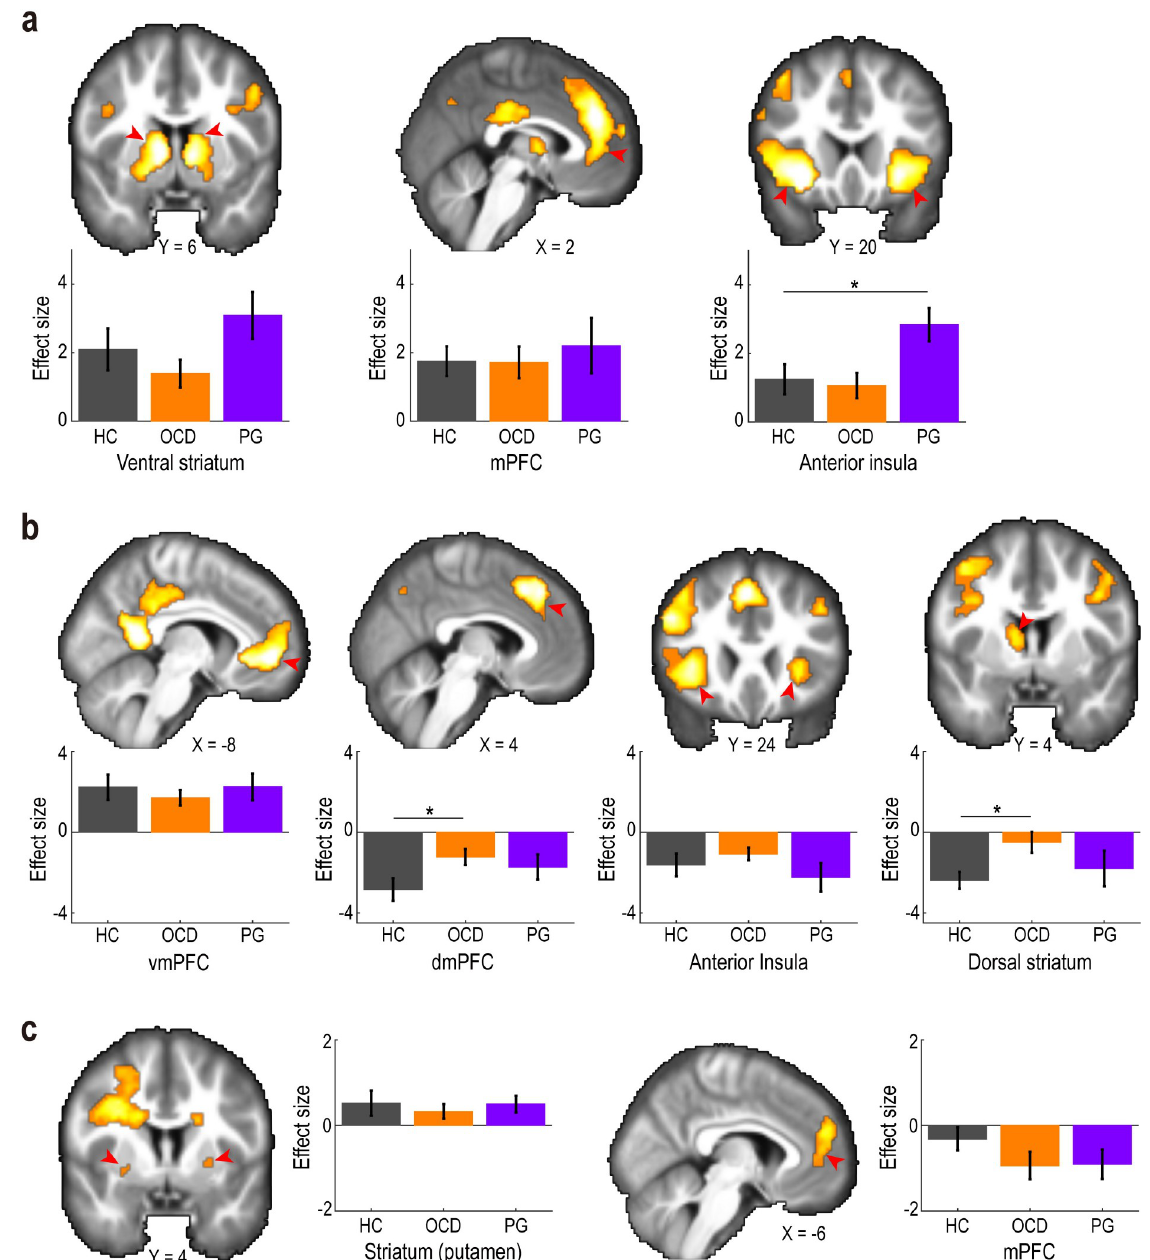
Fig 6. Neural correlates of reward prediction errors. (a) Positive reward prediction error in the reward trials. The activation maps are thresholded at P < 0.0005 (uncorrected) for display purposes. Red arrows indicate regions of interest. Bar-plots show effect sizes of the positive reward prediction error in the HC, OCD, and PG groups (mean ± SEM). Grey , healthy control (HC); orange , obsessive-compulsive disorder (OCD); purple , pathological gambling (PG). � P < 0.05 in a two-tailed Welch’s t test, Bonferroni-corrected for the two tests performed. mPFC, medial prefrontal cortex. (b) Negative prediction error in the reward trials. vmPFC, ventromedial prefrontal cortex; dmPFC, dorsomedial prefrontal cortex. The format is the same as in (a). (c) Unitary reward prediction error in the avoidance trials. The format is the same as in (a). Summary data to reproduce the figure are available at https://osf.io/v7em5/.